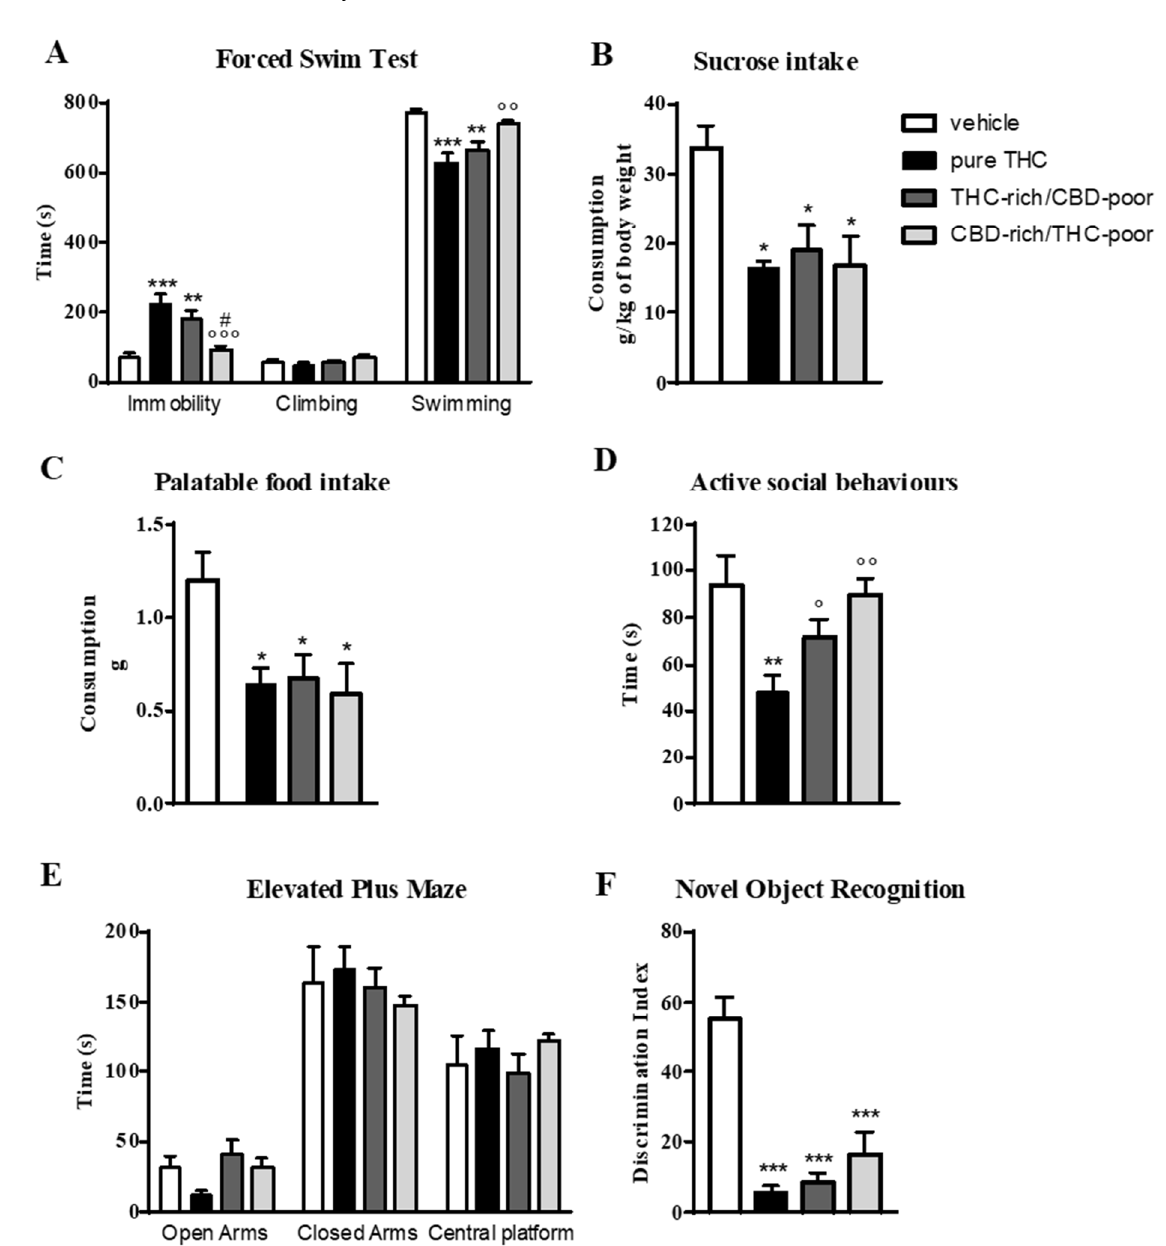
Figure 1. Behavioral responses of adult female rats following adolescent administration of pure THC or THC/CBD combinations in the forced swim test (panel A ), sucrose intake (panel B ), palatable food intake (panel C ), social interaction test (panel D ), elevated plus maze (panel E ) and novel object recognition test (panel F ). Data are expressed as mean ± SEM of 6 animals per group. * p < 0.05, ** p < 0.01, *** p < 0.001 vs. vehicle; ◦ p < 0.05, ◦◦ p < 0.01, ◦◦◦ p < 0.001 vs. pure THC; # p < 0.05 vs. THC-rich/CBD-poor. One-way ANOVA followed by Tukey’s post-hoc